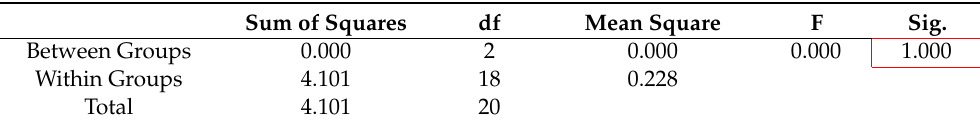
Table 3. Results of one-way ANOVA with the k value as 3, 5, and 7 (average prediction time for each